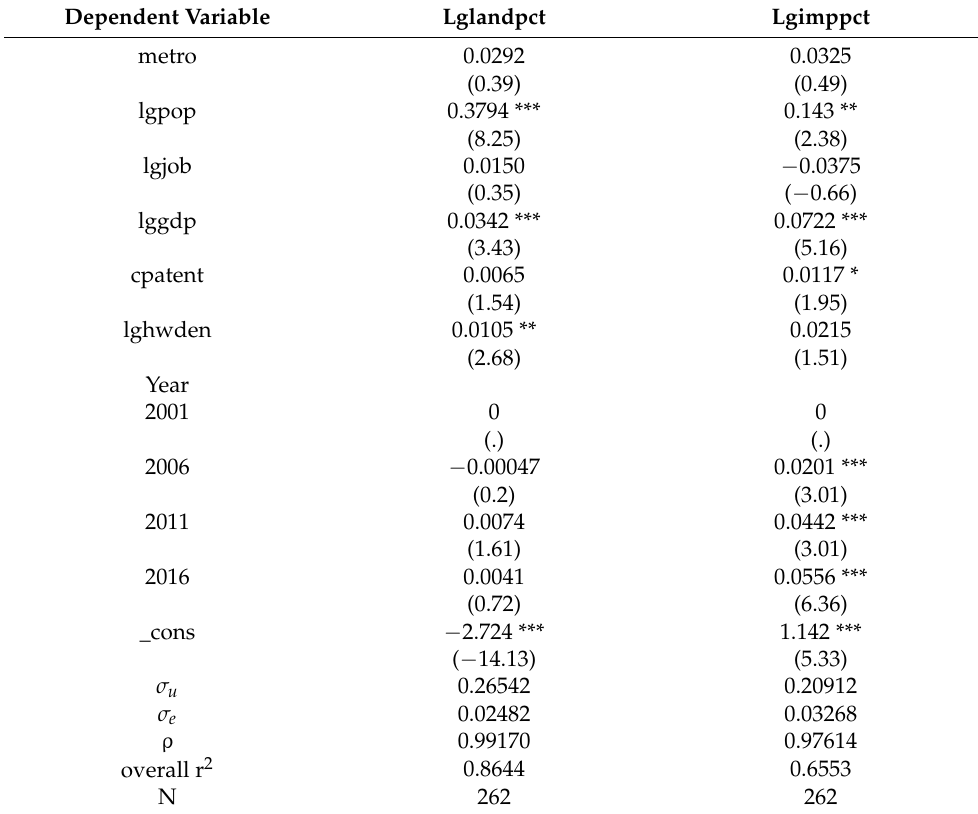
Table 4. Results of the mixed-effect